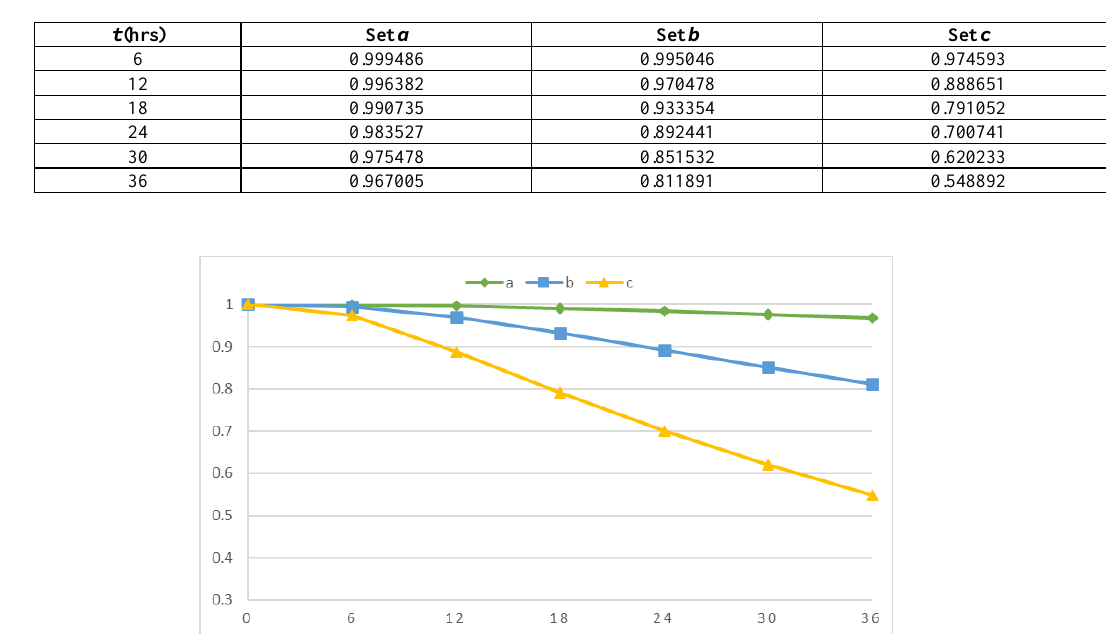
Table 2. The bitcoin dependability under sets a, b, c .